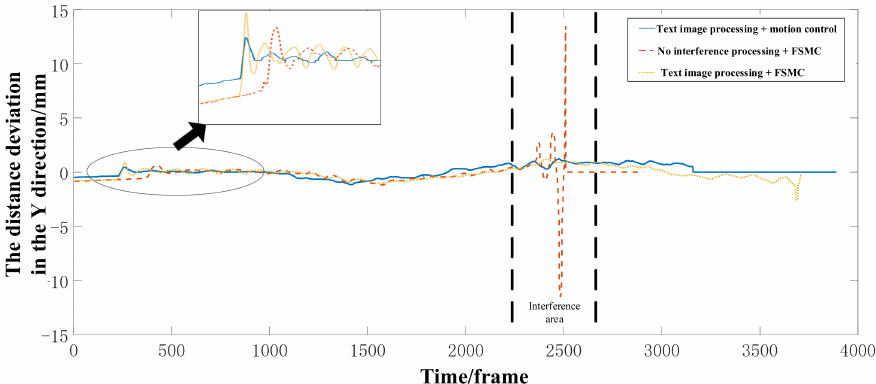
Figure 18. Comparison of real vehicle operation effect.